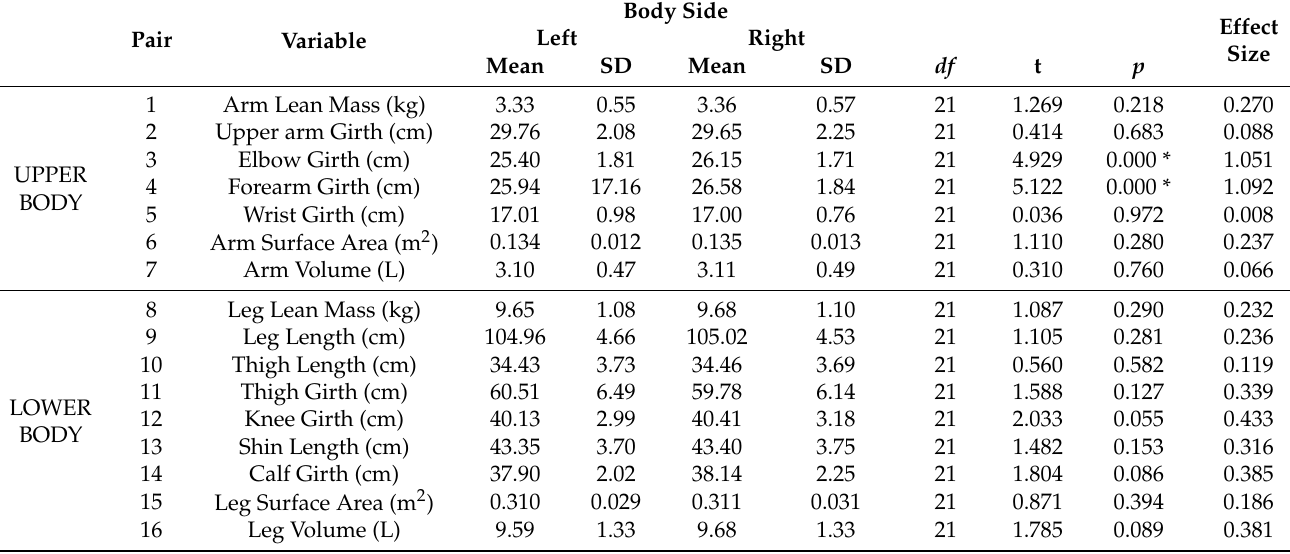
Table 3. Mean ( ± SD) values for left and right morphological variables with a paired t -test between paired variables of the HPG of road